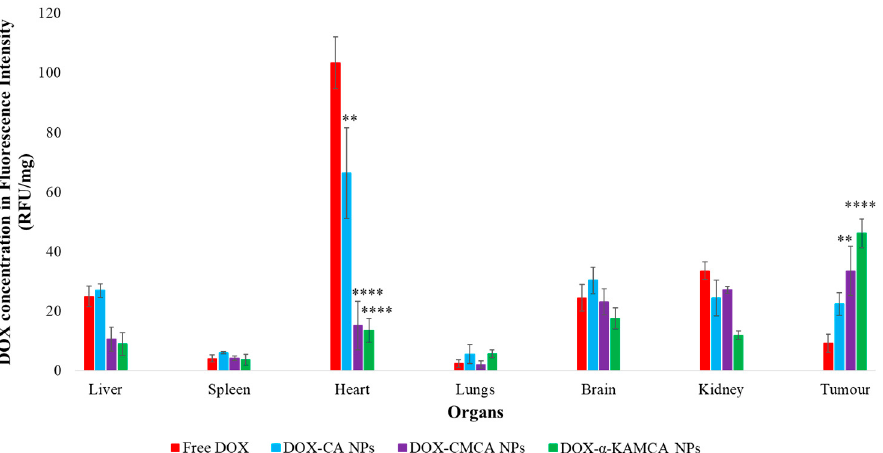
Figure 8. Biodistribution of free DOX, DOX-loaded CA NPs, DOX-loaded CMCA NPs, and DOX-loaded α -KAMCA NPs in the 4T1 murine breast cancer cell line-induced tumor mouse model at 24 h of treatment. Values were significant (*) at a p -value of 0.01 to 0.05, very significant (**) at a p -value of 0.001 to 0.01, and extremely significant (****) at a p -value < 0.0001 vs. the same treatment with free DOX at a CI of 95%. Blood Serum: At 2 h post intravenous (IV) injection (Table 1), the concentration of DOX in the blood serum was significantly higher for CA (538.13 ± 37.01 ng/100 µL), CMCA (339.01 ± 19.64 ng/100 µL), and α -KAMCA (877.21 ± 9.33 ng/100 µL) NPs compared to the free drug. In contrast (Figure 6),